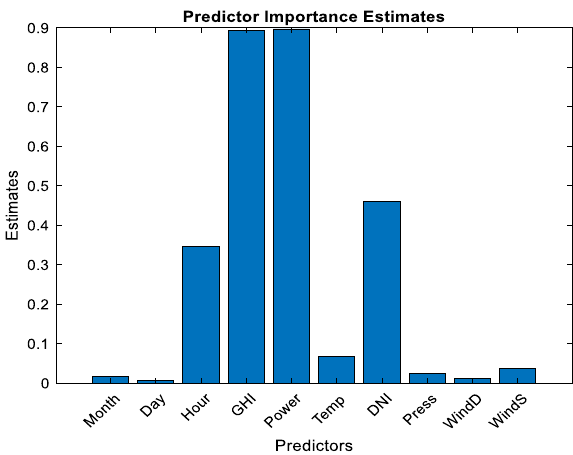
Fig. 11 The importance of features based on the Decision Tree (DT)